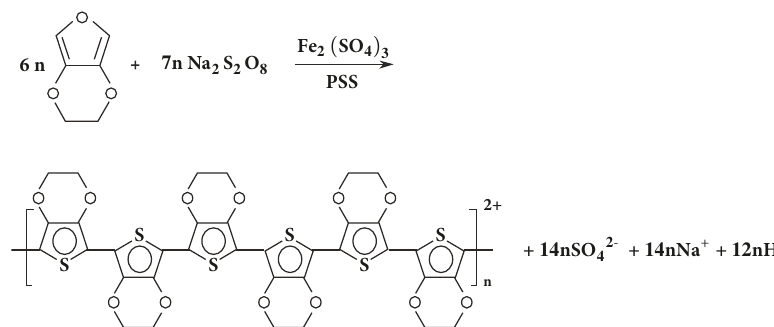
Figure 4: Reaction scheme for the PEDOT synthesis using Sodium peroxodisulfate as an oxidant.